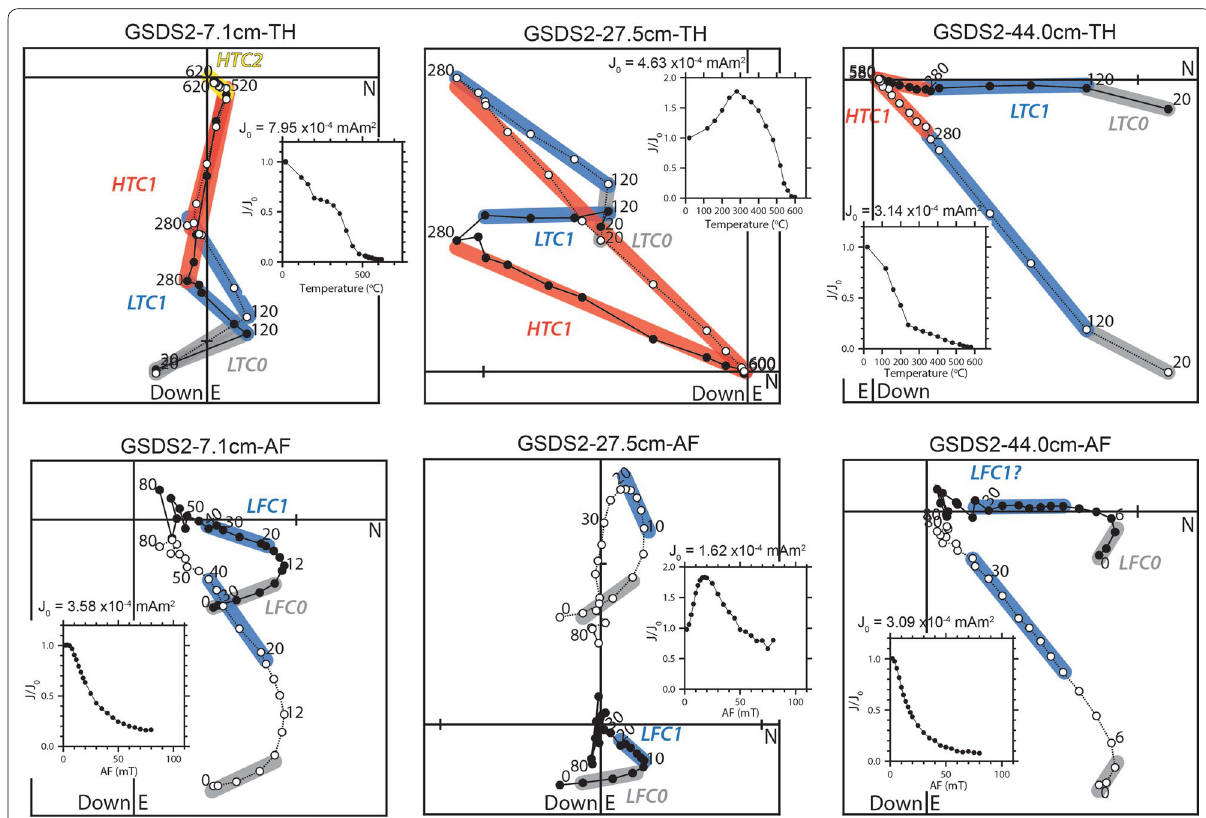
Fig. 4 Zijderveld diagrams and intensity decay curves of stepwise TH demagnetization results for three horizons (7.1, 27.5 and 44.0 cm depth levels; 8.2, 29.0 and 49.0 cmcd, respectively. See text for the definition of cmcd) sampled during the second sampling (GSDS2), compared to those of stepwise AF demagnetization result for adjacent specimens from the same depth level. On the Zijderveld diagrams, the LTC0, LTC1, HTC1 and HTC2 segments for TH‑treated results are illustrated with gray, blue, red, yellow bars, respectively, and LFC0 and LFC1 segments for AF‑treated results are illustrated with gray and blue, respectively. Other symbols on the Zijderveld diagram are same as in Fig.